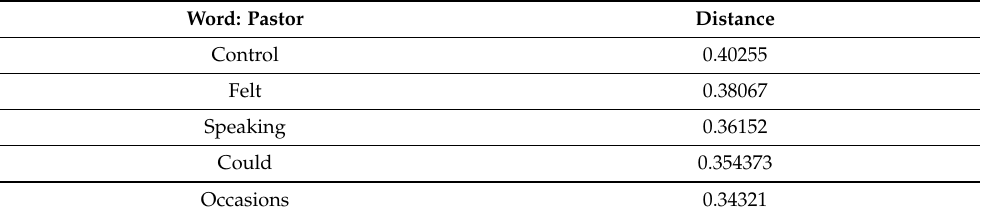
Table 6. Closest words to “Pastor”.